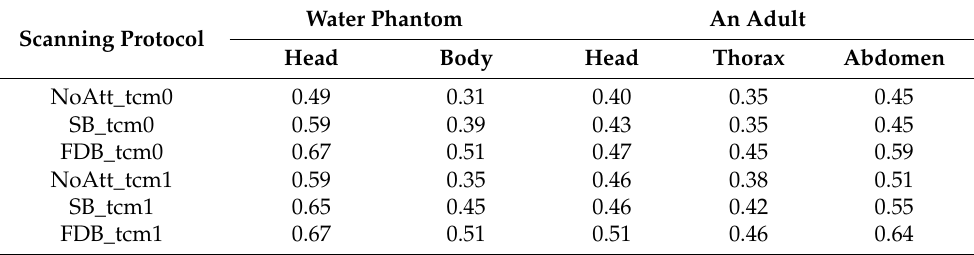
Table 6. NPS isotropy of reconstructed images using different scanning